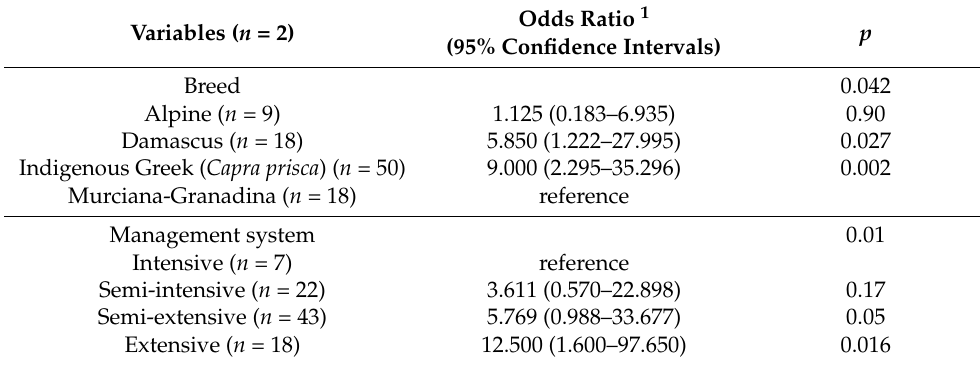
Figure 4. Proportion of herds with increased somatic cell counts (>0.75 × 10 6 cells mL − 1 ) in the bulk-tank milk of goat herds in Greece in accordance with the breed of goats therein. Table 5. Results of multivariable analysis for increased somatic cell counts (>0.75 × 10 6 cells mL − 1 ) in the bulk-tank milk of goat herds in Greece (mixed effects logistic regression and analysis with only herds with the four most frequently recorded breeds).